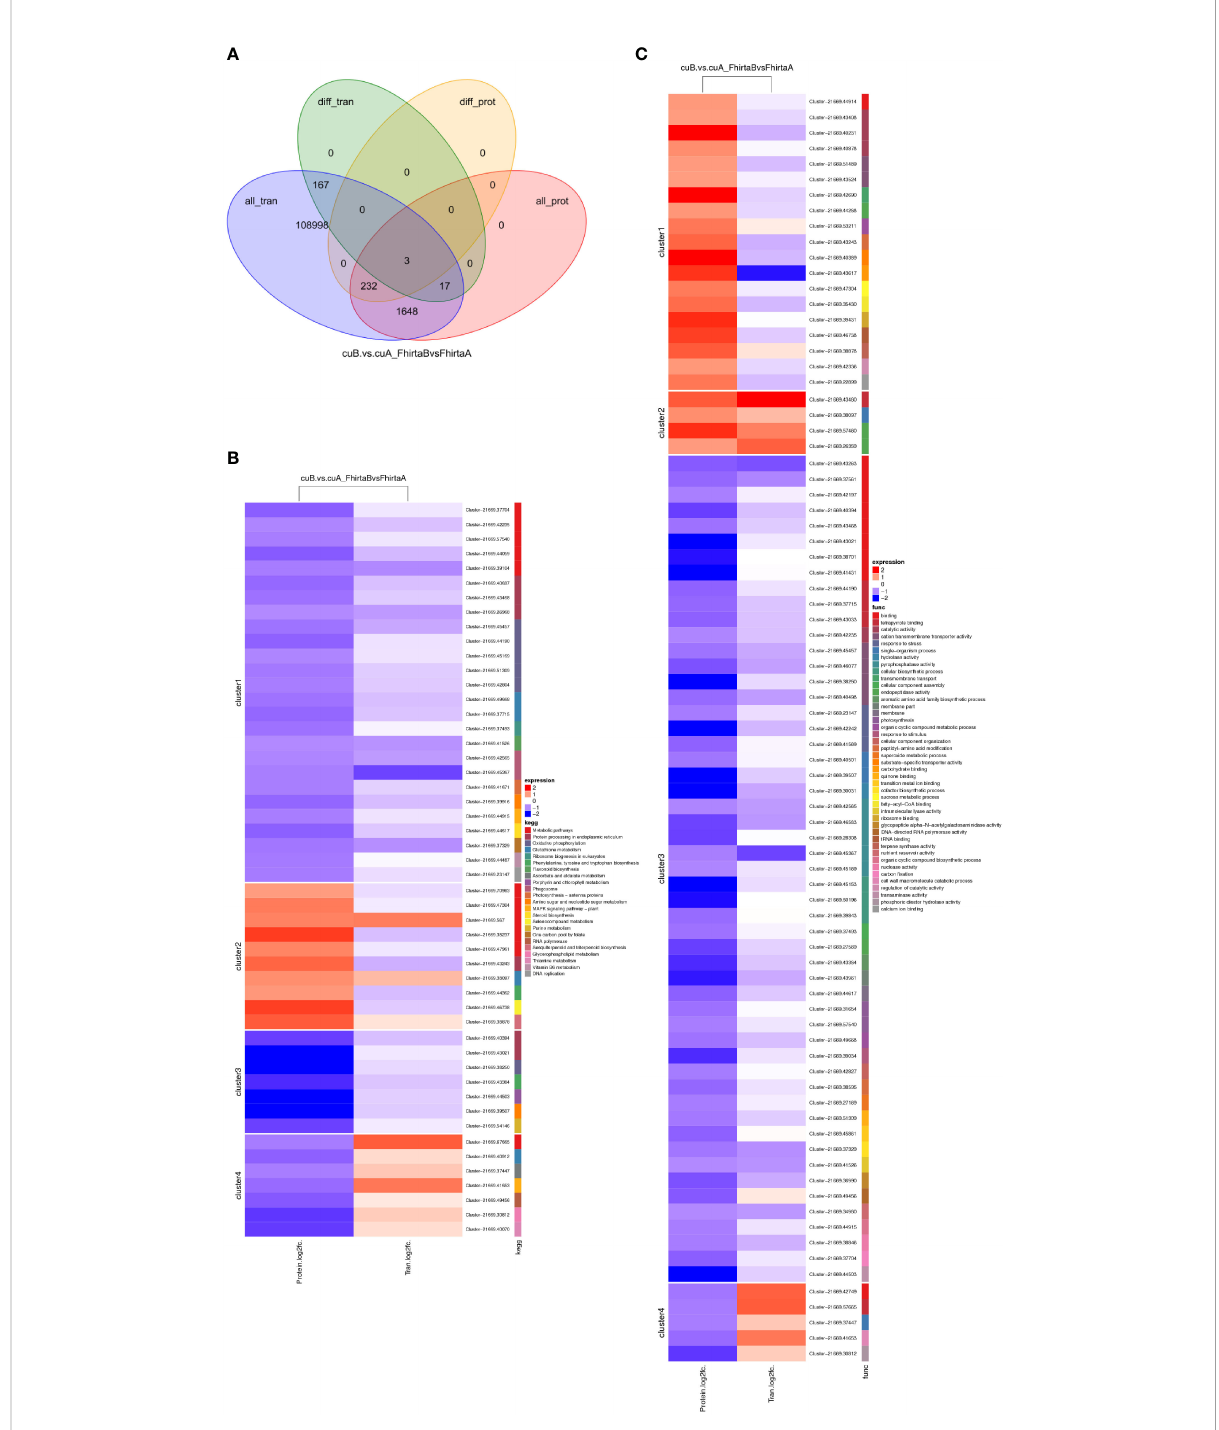
FIGURE 5 Correlation analysis of transcriptome and proteome. (A) Venn diagram of proteins expression and genes expression. (B) KEGG pathway of DEGs corresponding to DEPs. Red represents up-regulated and green represents down-regulated. FhirtaA VS FhirtaB represent multiples of transcript expression in both A phase and B phase of F hirta bracts. CuA VS CuB represents multiples of protein expression in both A phase and B phase of F hirta bracts. Fold Change (FC) represents multiples of genes/proteins expression in two groups. (C) GO categorization of DEGs corresponding to